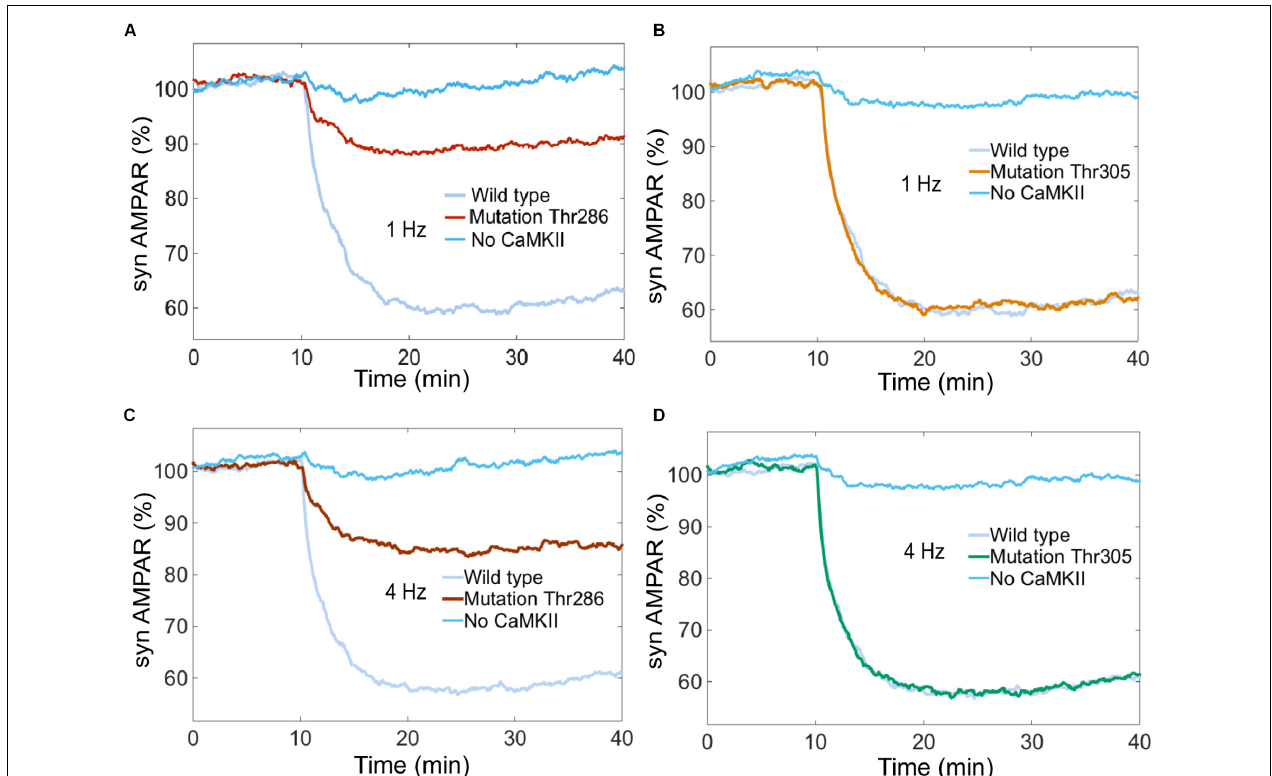
FIGURE 10 | Thr286 phosphorylation site has an important effect on LTD induction. Time courses of depression induced by 100 of Ca 2 + pulses at 1 and 4 Hz. Each curve shows the mean time course calculated for 100 iterations of the model. The magnitude of the depression was measured as percentage for synaptic AMPARs when the system is complete (wild type) and mutated at the Thr286 or Thr305 sites. (A) and (C) show LTD impairment when Thr286 phosphorylation site has been deleted for calcium stimulation at 1 and 4 Hz, respectively. (B) and (D) do not show any change in the amount of LTD when Thr305 phosphorylation site has been deleted. (A–D) show that CaMKII activity is required for LTD